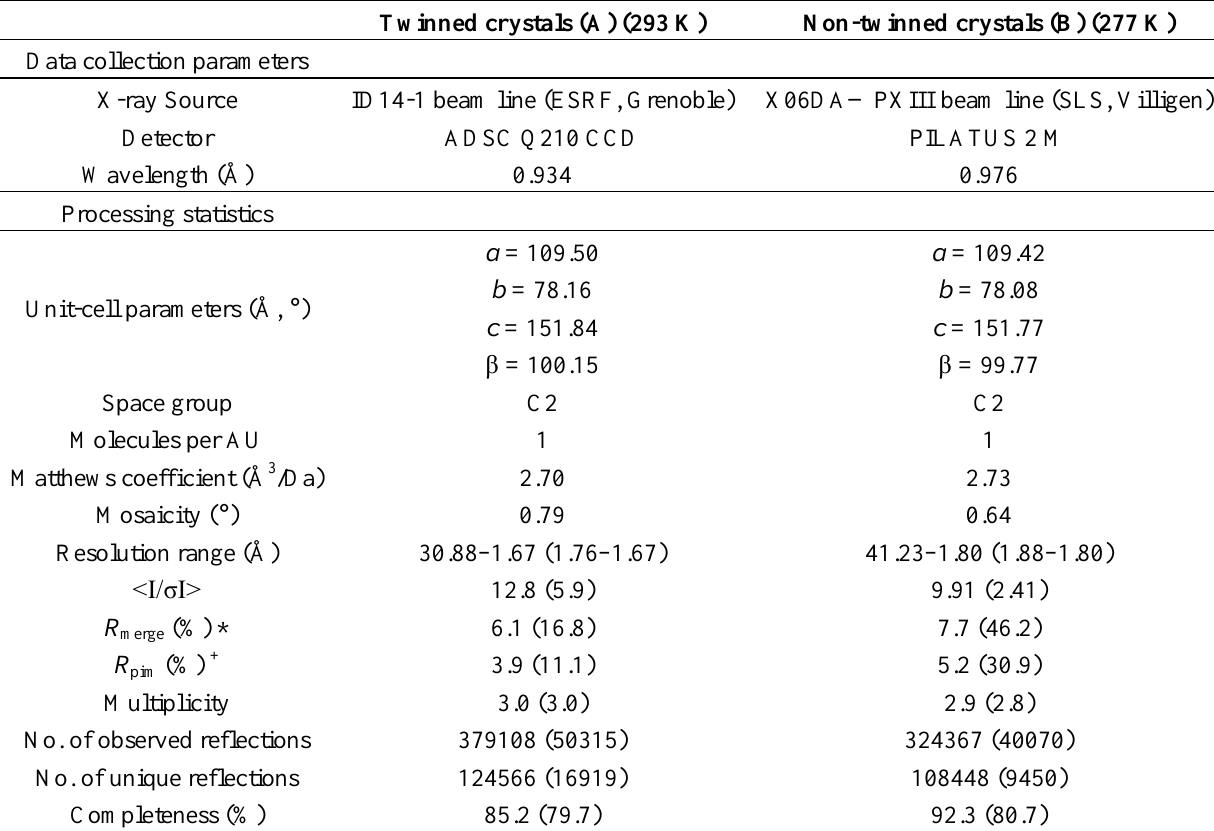
Table 1. Data-collection and processing statistics for two types of PaoABC crystals. Values in parentheses are for the highest resolution